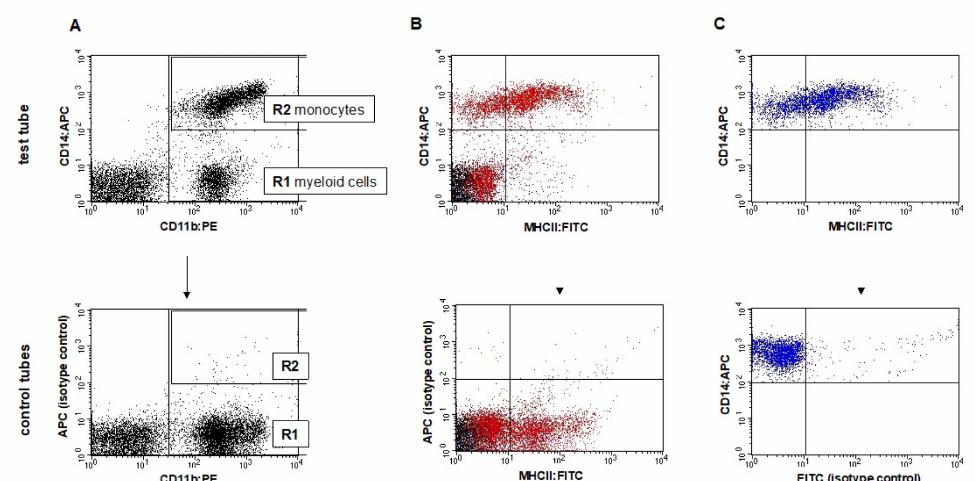
Figure 2. Representative dot plots depicting gating strategy of peripheral blood monocytes of dog with lymphoma. ( A ) Regions were set for all CD11b+ myeloid cells (R1) and for CD14+ monocytes (R2) on the CD14:APC vs. CD11b:PE double fluorescence dot plot; ( B ) distribution of all leukocytes (CD11b+ cells—red color) and ( C ) monocytes (from the R2 region—blue color) according to the expression of CD14 and MHCII. Bottom-row dot plots show isotype controls, separate for each Ab: anti-CD14 ( A , B ) and anti-MHCII ( C ). Controls allowed us to set the